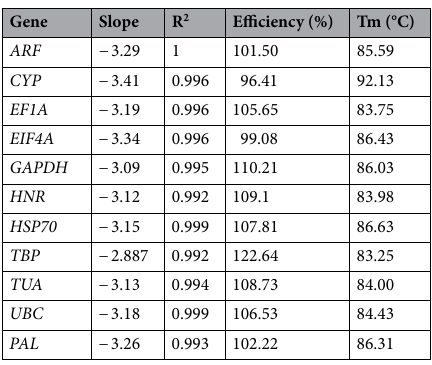
Table 2. Parameters derived from RT-qPCR analysis—slope, regression coefficient (R 2 ), reaction efficiency and melting temperature of the amplicon